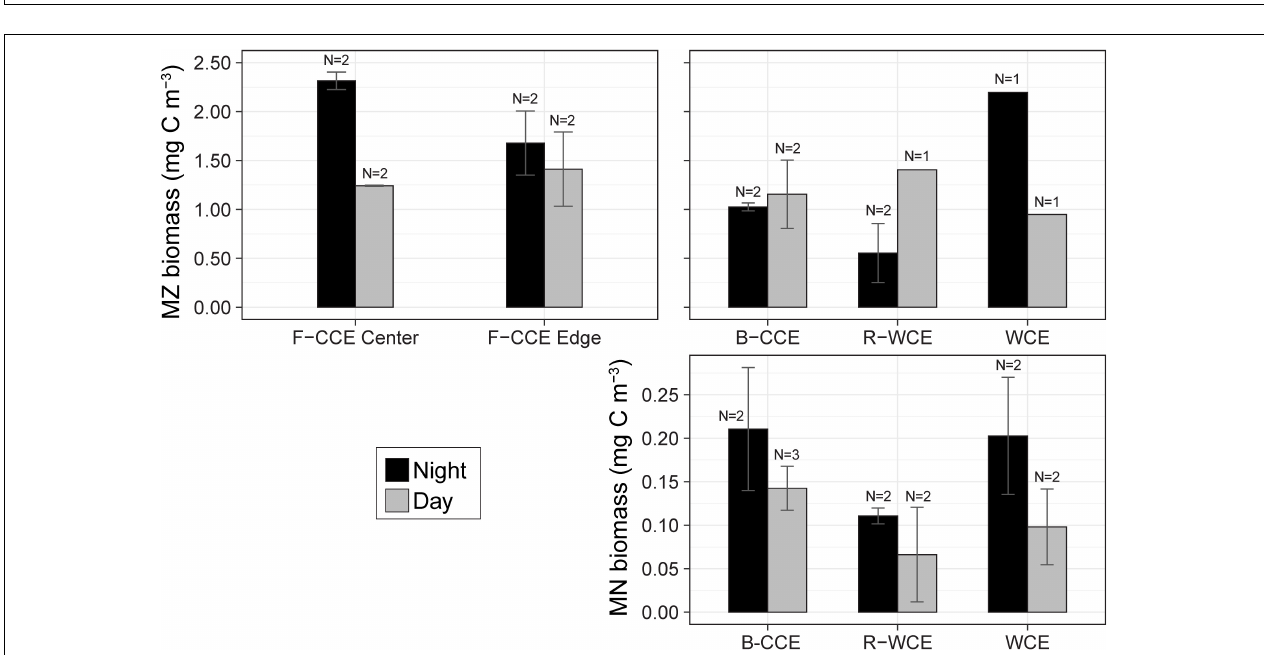
FIGURE 3 | Total water column mean mesozooplankton (MZ; top ) and micronekton (MN; bottom ) biomass (mg C m − 3 ) in the top 500 (MZ) and 1000 m (MN) during the night (black) and day (gray) at the F-CCE Center, F-CCE Edge, B-CCE, R-WCE, and WCE. Bars indicate ± standard error of the mean.